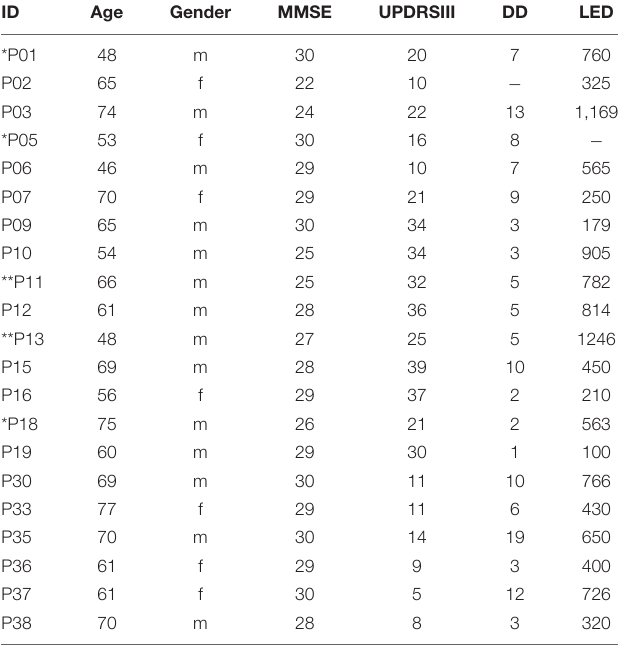
TABLE 1 | Characteristics of persons with